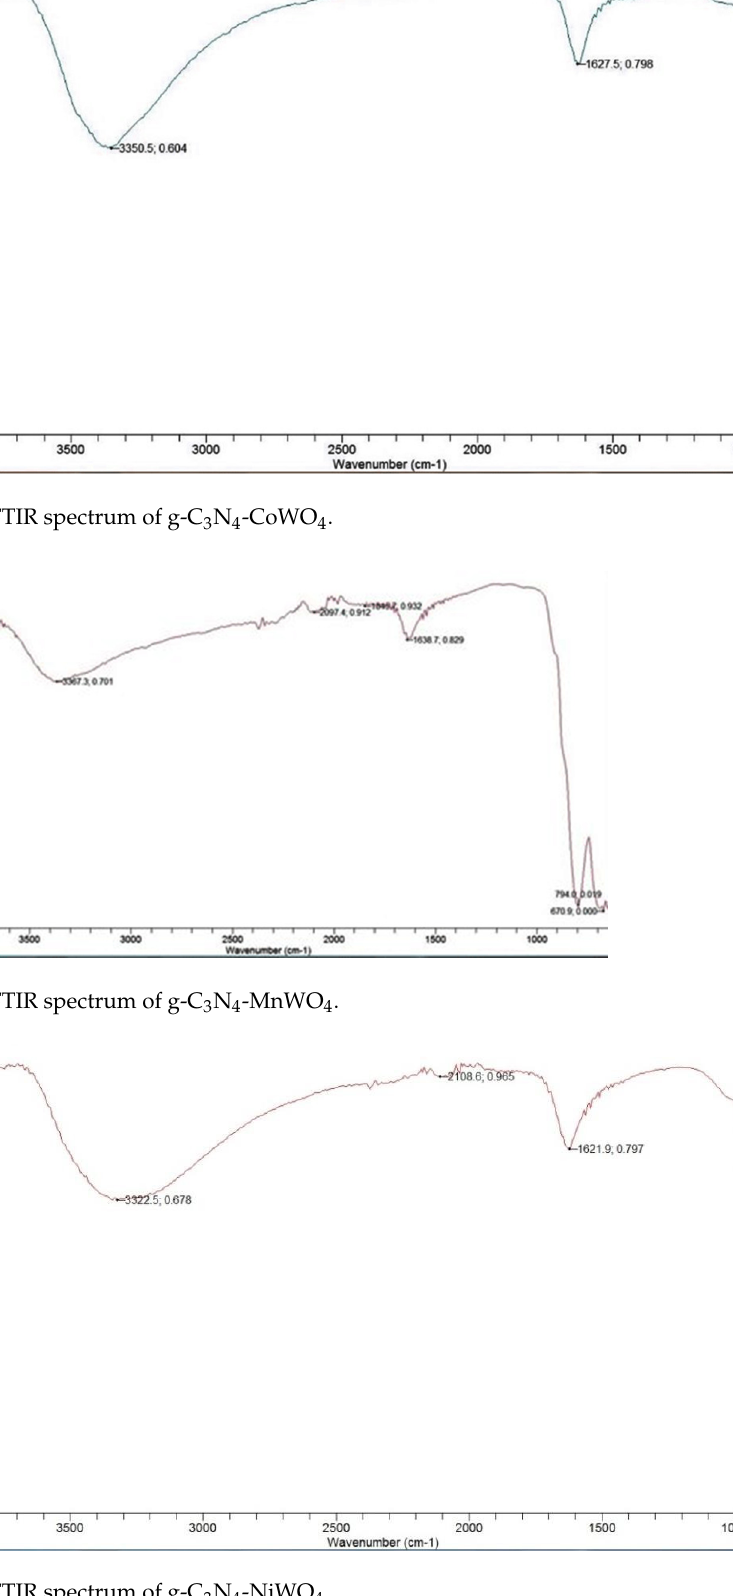
Figure 5. FTIR spectrum of g-C 3 N 4 -NiWO 4.